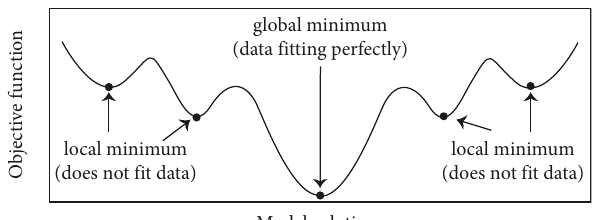
Figure 1: Schematic diagram of cycle-skipping issues in waveform